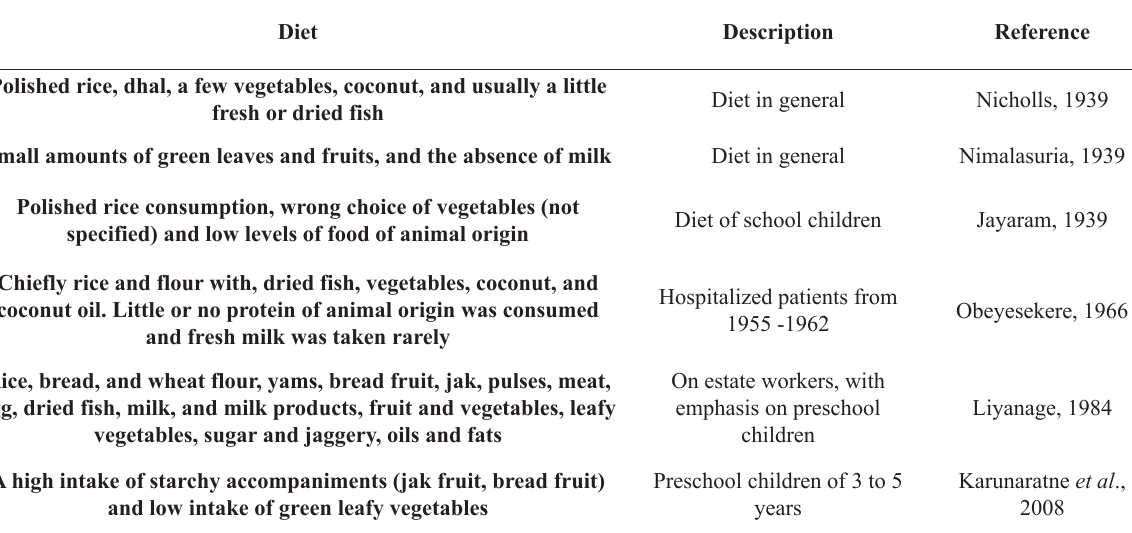
Table 1: The description of the diet consumed by Sri Lankans in a chronological sequence, as described in different research studies. Diet Polished rice, dhal, a few vegetables, coconut, and usually a little fresh or dried fish Small amounts of green leaves and fruits, and the absence of